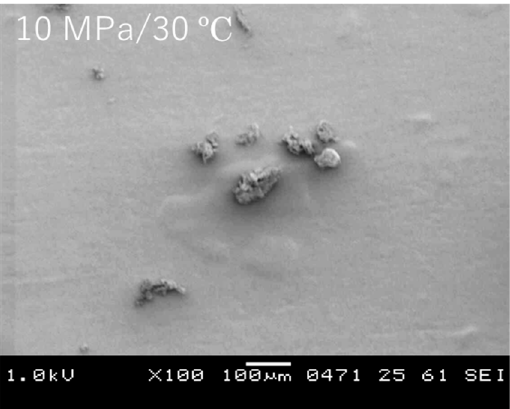
Figure 4. Morphology of Lf loaded shellac microparticles produced at different P and T conditions of supercritical CO 2 in the PGSS process. Table 1. Influence of process parameters on particle size distribution and encapsulation efficiency of Lf microcapsules. Experimental Conditions